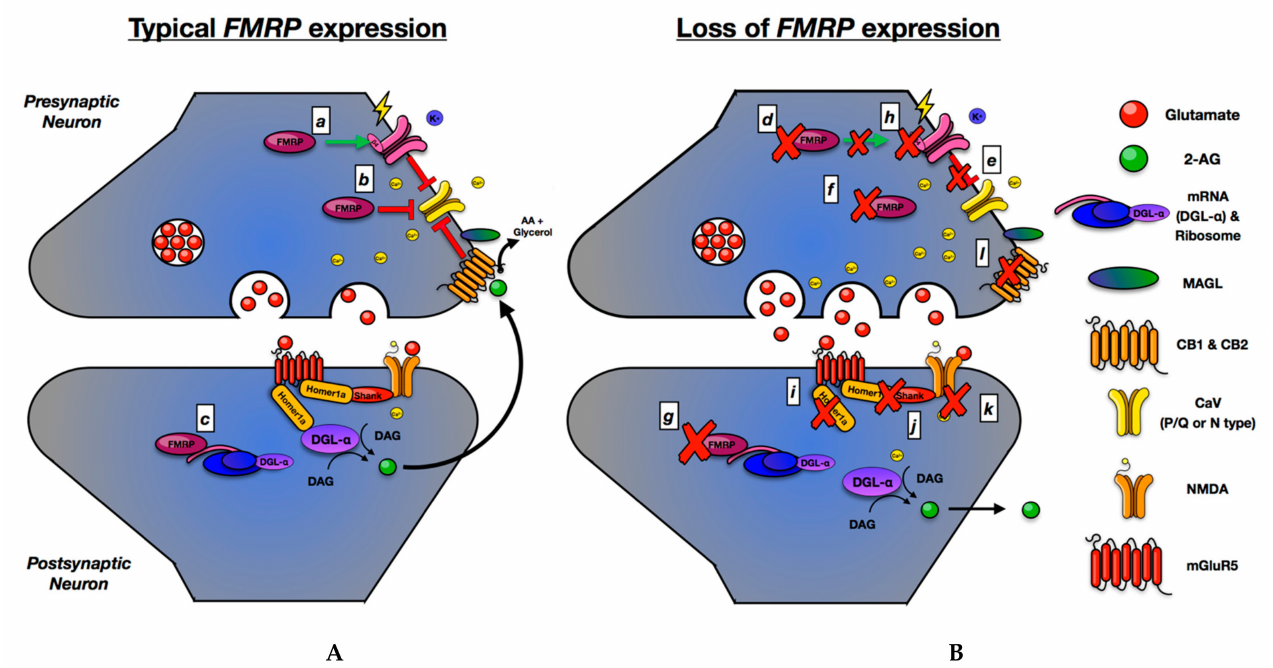
Figure 2. FMRP regulation of presynaptic activity. FMRP contributes to presynaptic regulation ( A ) by (a) stimulating the BKCa channel to inhibit CaV channels, (b) directly inhibiting Ca V channels, or (c) controlling the translation and localization of the eCB producing enzyme diacylglycerol lipase α (DGL- α ) in the post-synaptic density. DGL- α exists in a complex (synaptosome) with the scaffolding protein Homer1a and mGluR5. DGL- α production of the CB1 ligand 2-AG occurs due to mGluR5 activity (Ca 2+ independent) or NMDA activity (Ca 2+ dependent). CB1 responds to 2-AG stimulation by inhibiting P/Q and N-type Ca V channels. The absence of FMRP due to the FMR1 mutation ( B ) results in a loss of appropriate presynaptic Ca V channels regulation by (d,e) BKCa channels and (f) direct FMRP interactions; (g) absence of post-synaptic FMRP results in delocalized DGL- α and 2-AG production. Mutations in (h) the β 4 regulatory unit of BKCa channels, (i) CB1, (j) Homer1a, (k) Shank3, and (l) NMDA channels have associations with syndromic and non-syndromic ASD. Each of these defects causes increased Ca 2+ entry and neurotransmitter release (computational dysfunction).